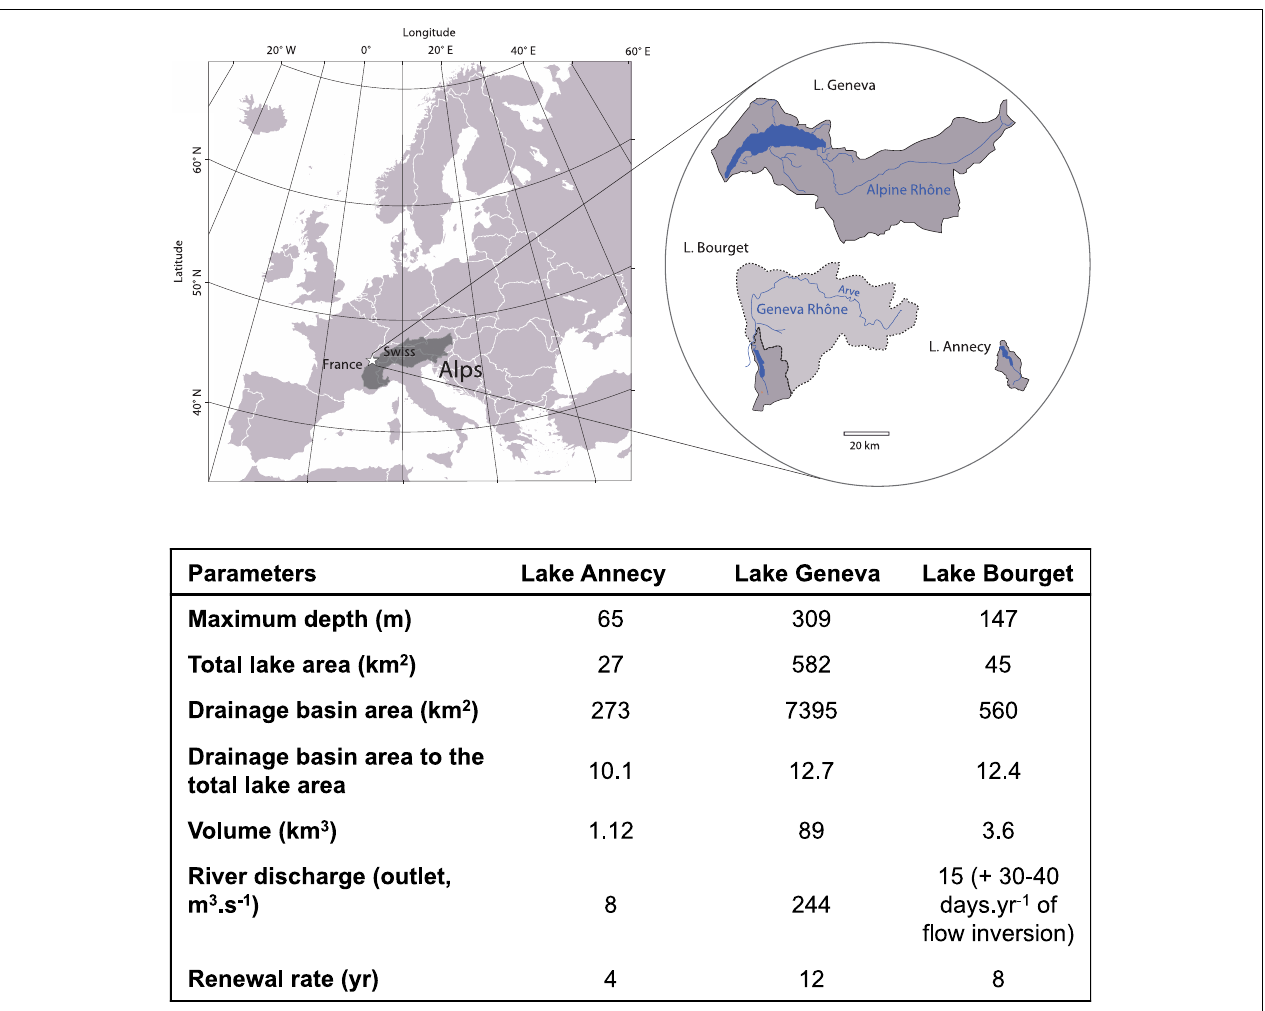
FIGURE 1 | Lakes location and geomorphological